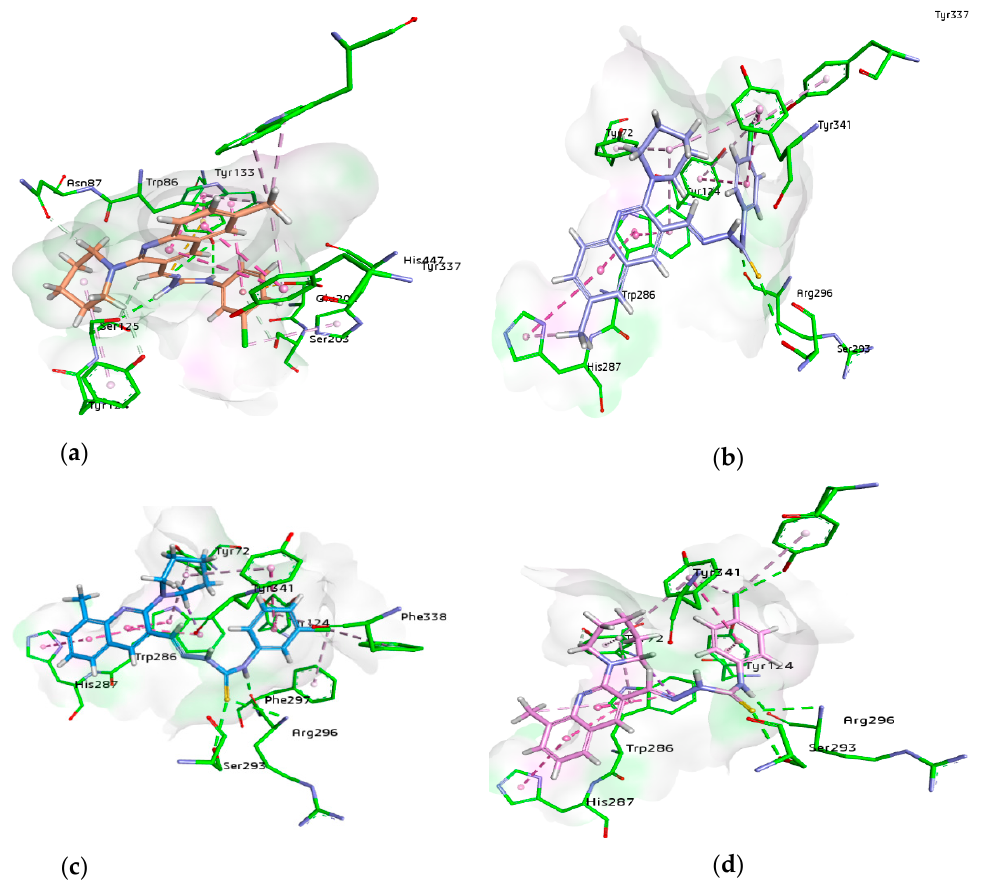
Figure 8. 3D binding modes of 5f ( a ), 5g ( b ), 6f ( c ), and 6g ( d ) with the amino acid residue of AChE, hydrogen bonding is shown by green dashed line, hydrophobic interactions are shown by light purple color, dark pink dashed lines show π -T shaped, light pink color shows π - π stacked interactions, and purple color dashed lines show π -sigma type interactions.